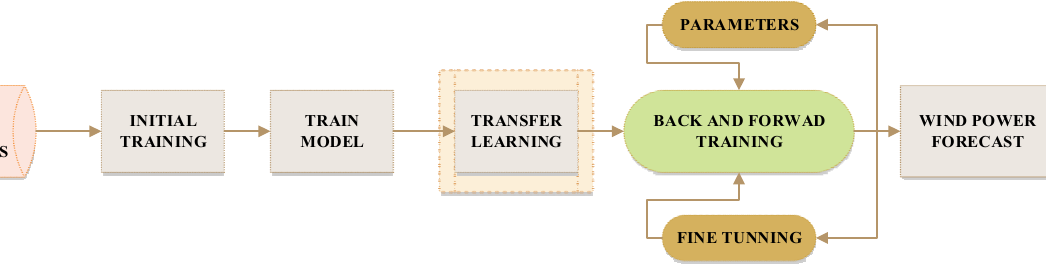
Figure 4. Overview of TensorFlow framework with transfer learning for wind power forecasting.